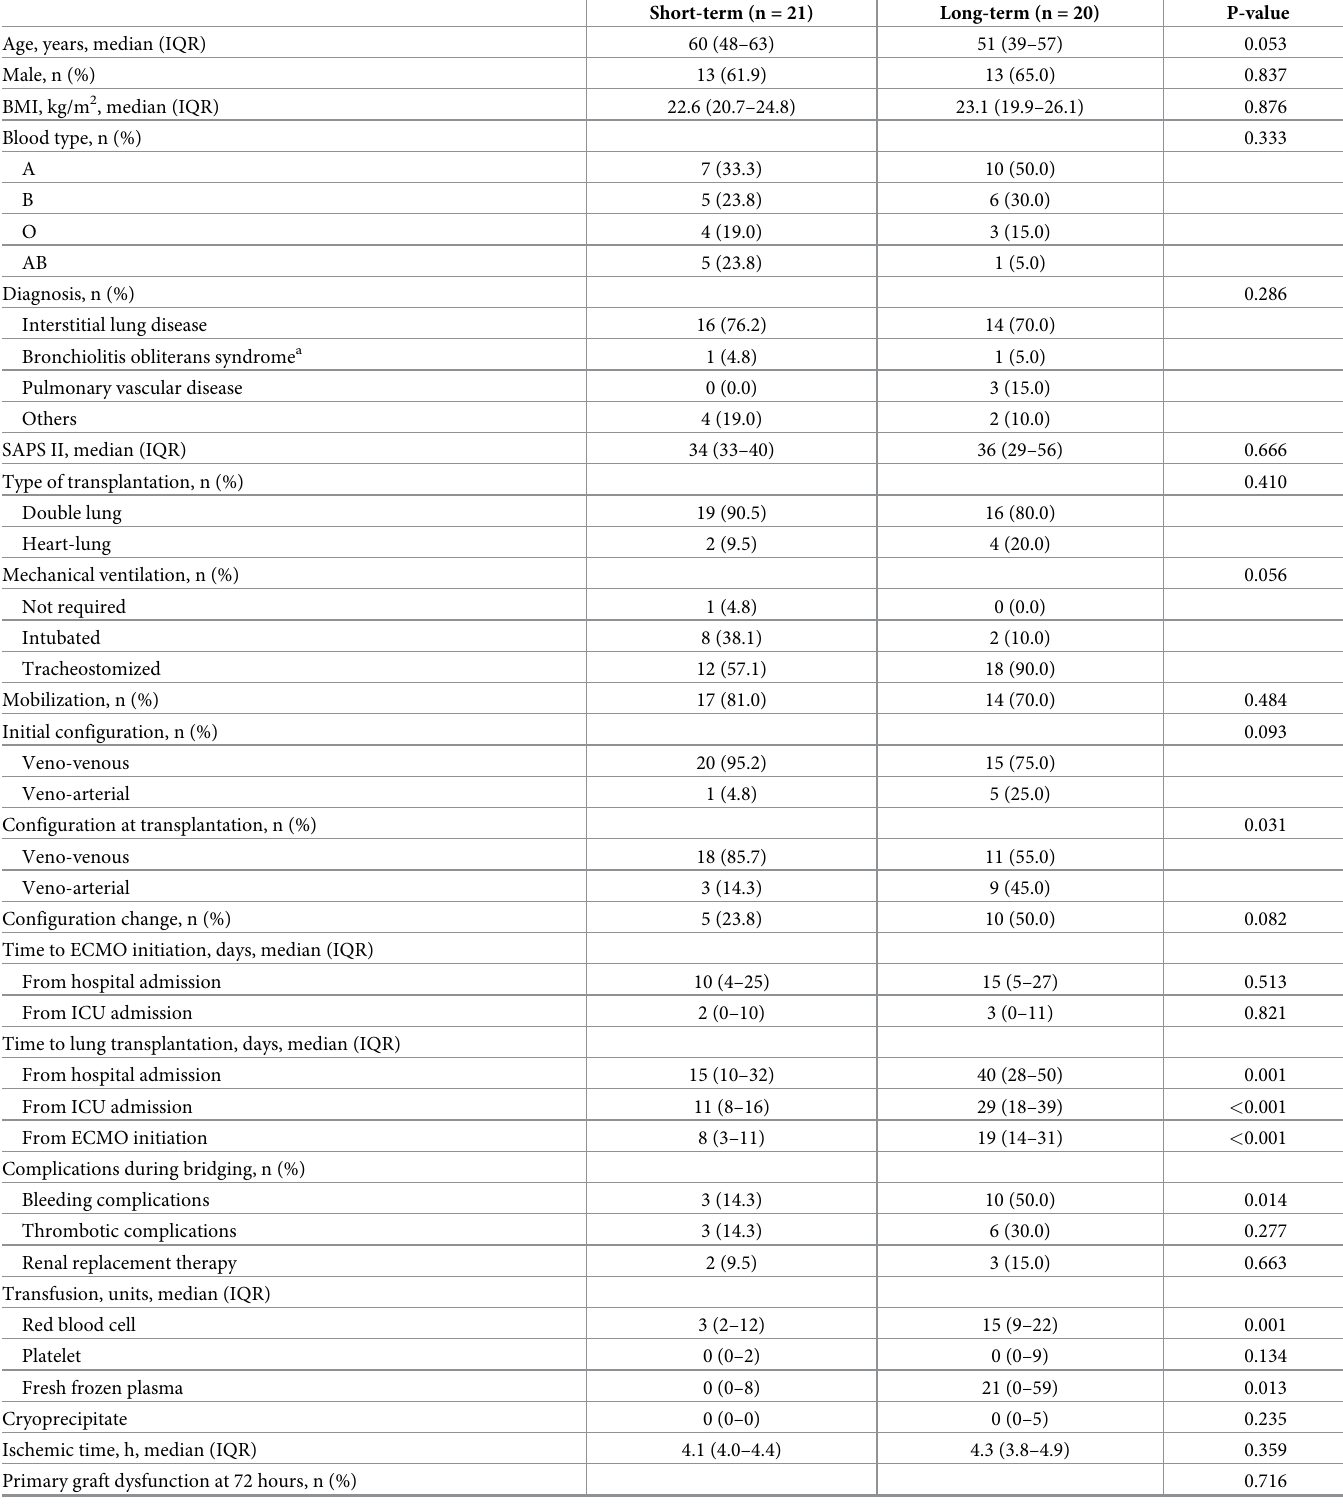
Table 2. Demographic and clinical characteristics of the short-term ( < 14 days) and the long-term ( � 14 days) BTT groups at the time of